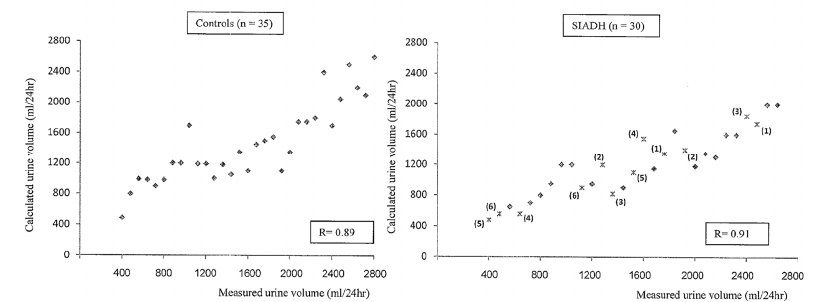
Figure 3. Correlation between the calculated urine volume and the measured values in 35 controls and 30 patients with chronic hyponatremia due to SIADH. In six patients, represented by a number in brackets, the values are given before and after treatment with urea (see Table 3). Further, 13 patients presented an estimated daily urine volume ≥ 2000 mL, associated with a high solute intake (> 900 mmol/24 h in 10 patients; Figure 4) and 19 patients presented a daily low solute intake <500 mmol, associated with a low urine volume (< 1000 mL/24 h in 13 patients).